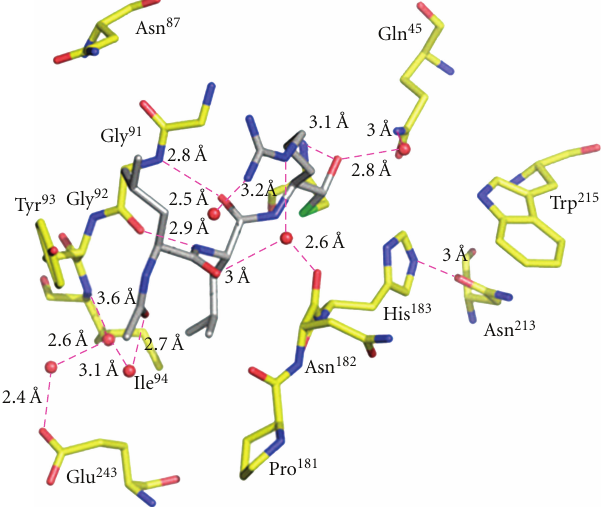
Figure 9: Interaction between falcipain-2 and E-64. The residues in the active site of falcipain-2 are colored blue and labeled, and E-64 is colored in grey. The interactions with enzyme and inhibitor are in pink [26].